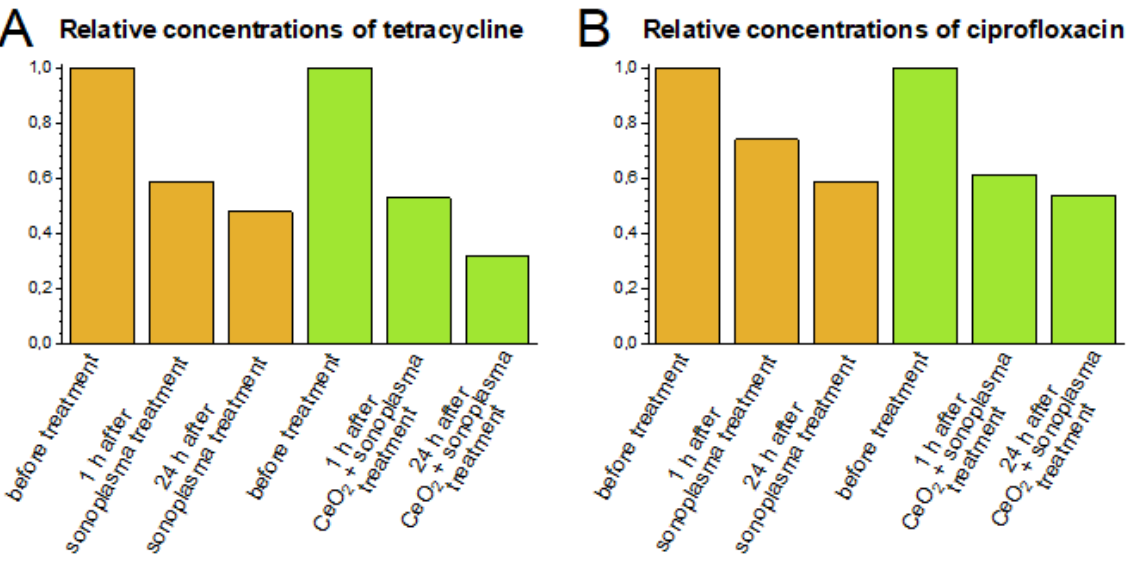
Figure 4. Relative concentrations of tetracycline ( A ) and ciprofloxacin ( B ) in solutions before treatment and 1 and 24 hours after the sonoplasma treatment, with and without CeO 2 . Antibiotics (tetracycline and ciprofloxacin) and the CeO 2 solution were added in a 10/1 molar ratio.